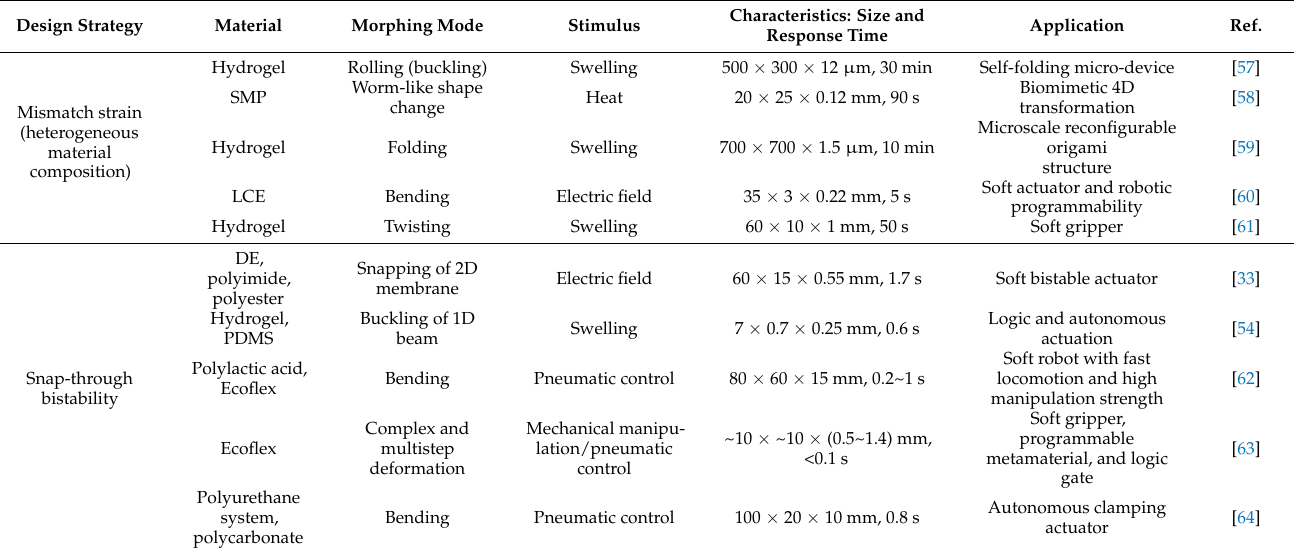
Table 1. Summary of representative shape transformations based on different design strategies, along with their characteristics and applications. Characteristics: Size and Response Time Application